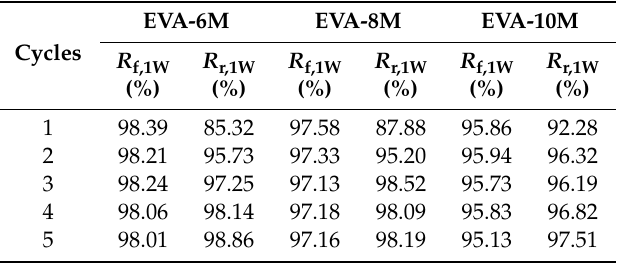
Figure 6. 2W-SME cycles under a constant stress of 0.27 MPa for ( a ) EVA-6M, ( b ) EVA-8M, and ( c ) EVA-10M. Table 2. One-way (1W)-SME of different EVA fiber under 0.27 MPa.